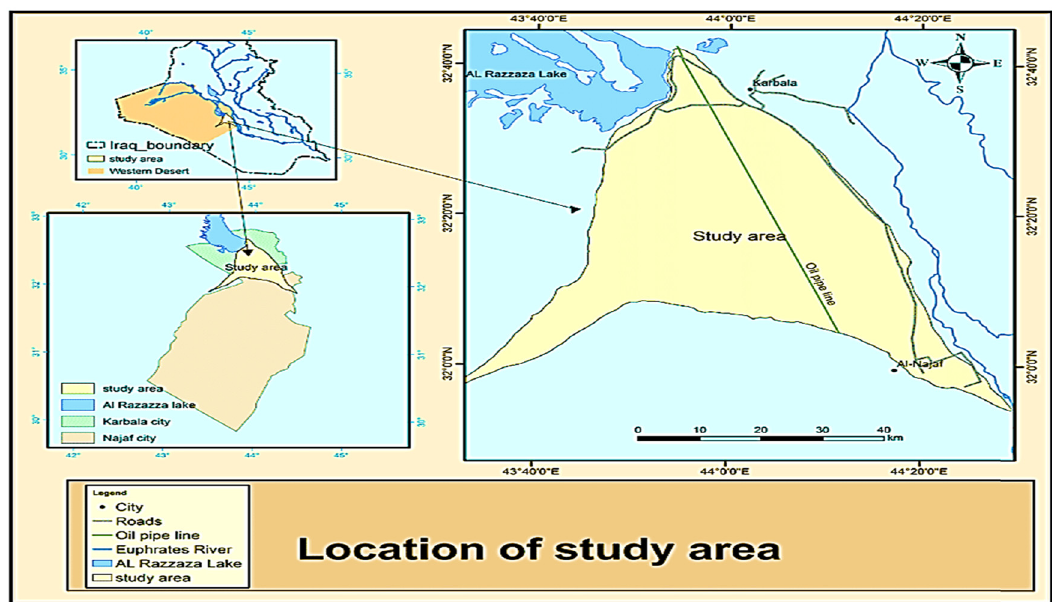
Figure 1: Location of study area ( Najaf and Kerbala plateau; Al - kubaisi et al., [ 11 ])